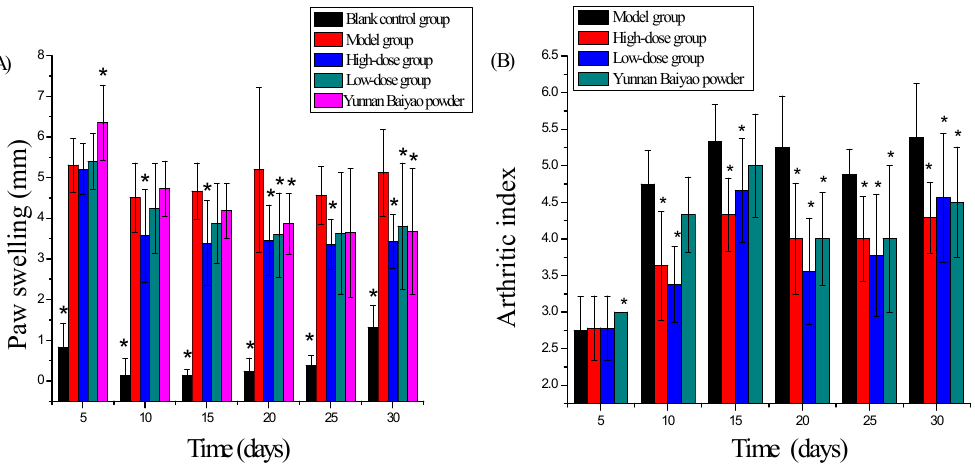
Figure 3. Effect of brucine gel on paw swelling ( A ) and arthritic index ( B ). Symbols represent statistical significance: * ( p < 0.05) when compared with model group.